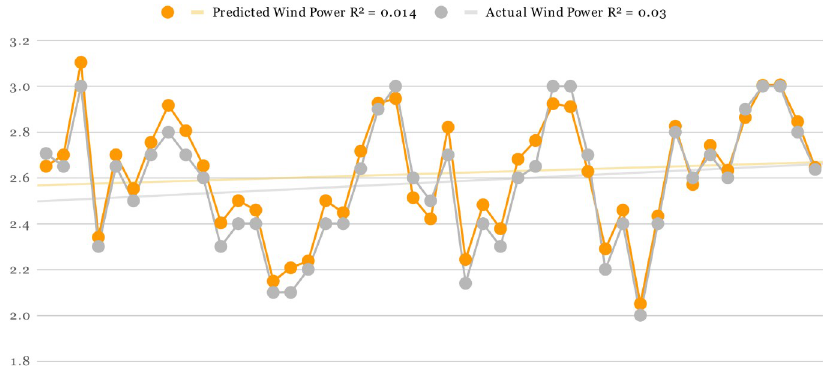
Fig 5. Predicted and actual power generation on Offshore Windfarm 1 based on Table 2 fine-tuned setting and proposed forecasting architecture.